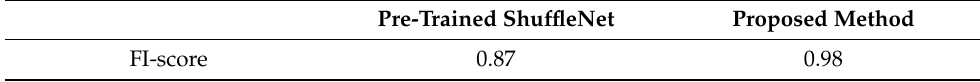
Table 4. F1-score result for the pre-trained ShuffleNet and proposed method.